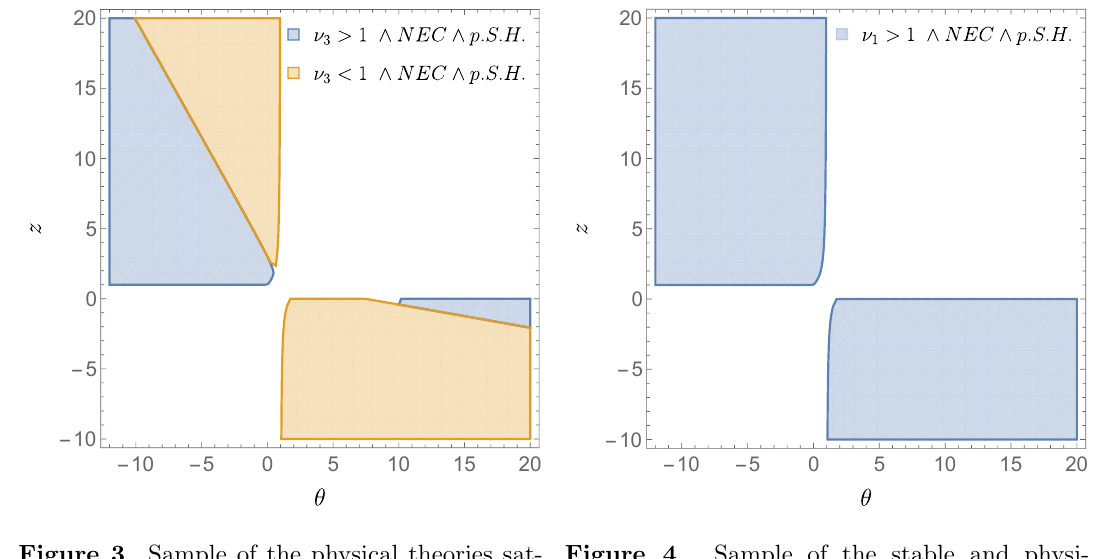
Figure 3 . Sample of the physical theories sat- isfying in addition the inequality (7.9) for (cid:13)uc- tuations along the x 3 direction, which belong to the upper and lower branches of two-point func- tion (7.11).